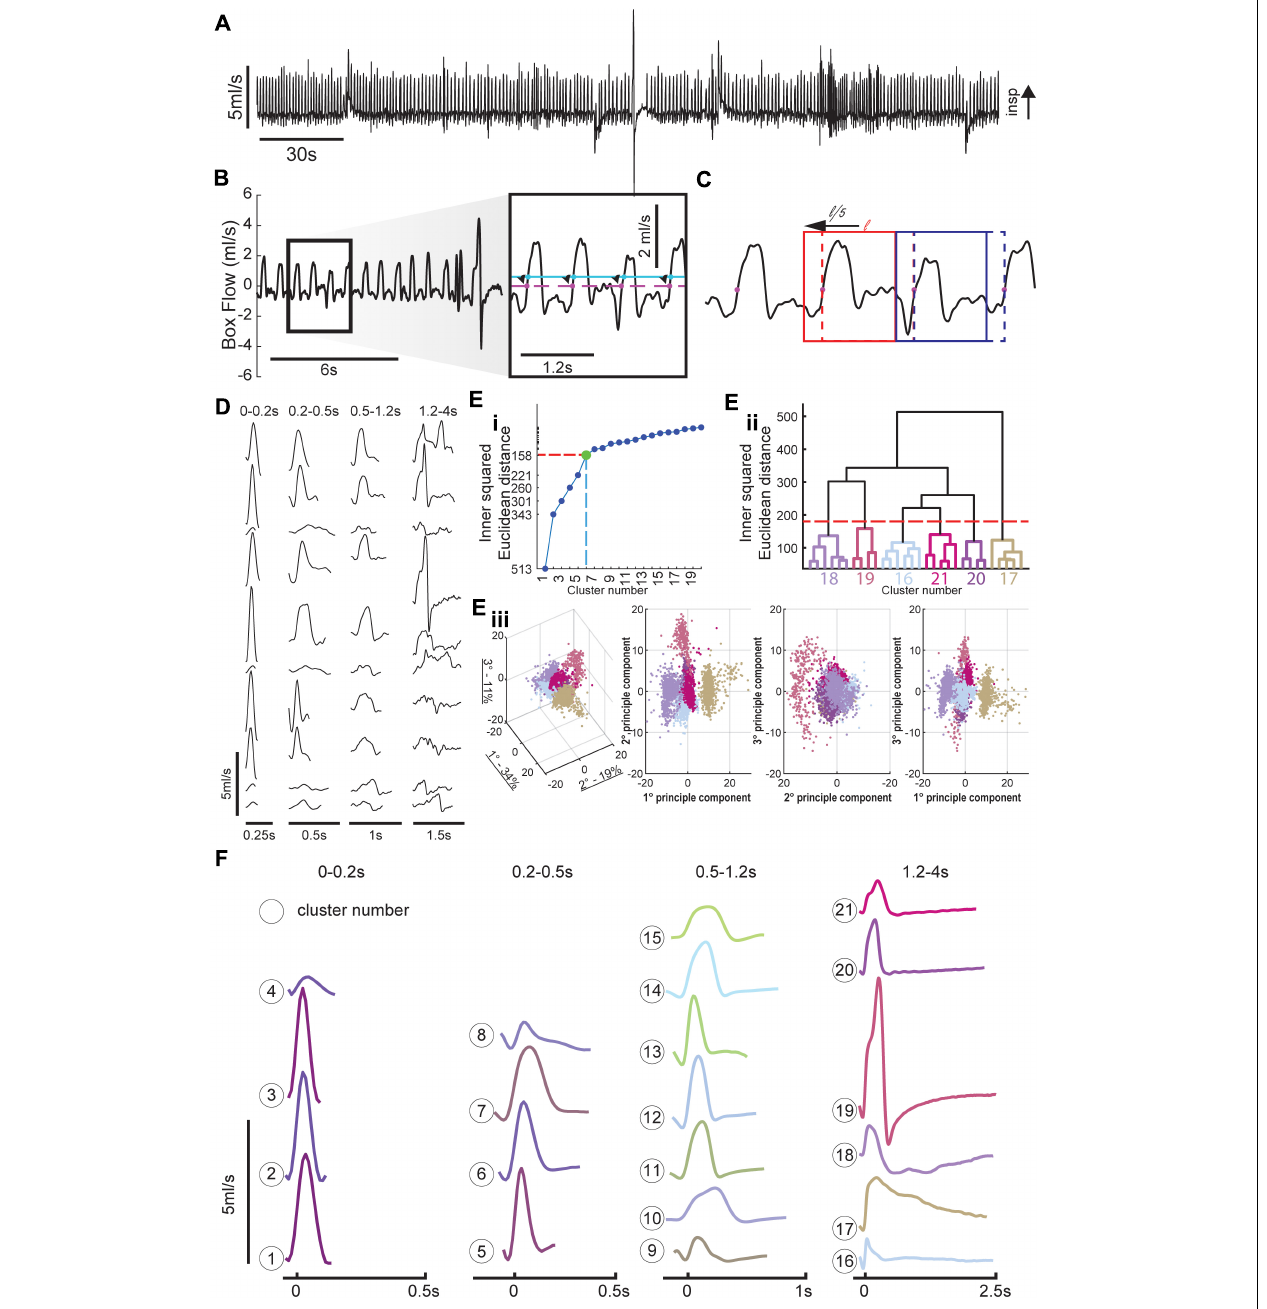
FIGURE 1 | Method for breath detection and respiratory waveform clustering. (A) Example plethysmography flow trace. (B) Inspiratory efforts were detected with a threshold of 0.1 ml/s to avoid accidental noise detections, the starting point of each breath was then set to the previous zero-crossing and ended at the start of the next breath. (C) Breath detection windows were shifted back in time 20% of the breath length (max of 100 ms) to capture the entire inspiratory effort. Two windows are shown at their original position (dashed box) and final position (solid line). Positive values indicate inspiratory activity. Breaths were separated into four time domains to allow for cluster sorting; these time domains correspond to distinct respiratory behaviors. (D) Example waveforms from several animals for each of the four time domains (sniffing, short tidal, long tidal, and very long breaths). (E) Cluster methodology. Long duration (1.2–4 s) breaths are used as an example to illustrate clustering method. The relationship between cluster number and variance is plotted to show how we determined the number of clusters within each time domain. A 30 cluster hierarchical linkage tree with the six cluster cut-off is shown to illustrate the variance between the clusters (height of line connecting the six clusters), and variance within clusters (height of lines in color coded subtree). Every breath with the prolonged breath duration is plotted in principle component (PC) space the amount of variance explained by the eigenvector is noted in the 3D PC space in the axis labels, the colors of the breath scatter points matches their assigned cluster. (F) Average waveforms for the 21 clusters, the average waveform length is equal to the mean + 1 standard deviation (SD) of the lengths of all waveforms within that cluster.